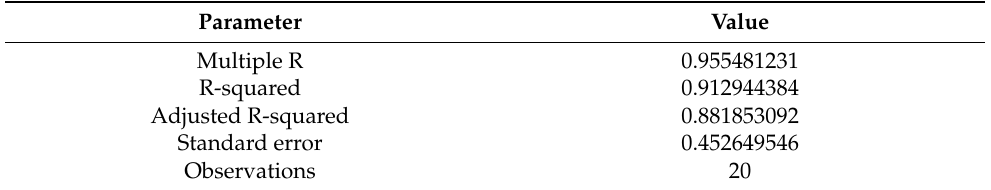
Table 4. Regression